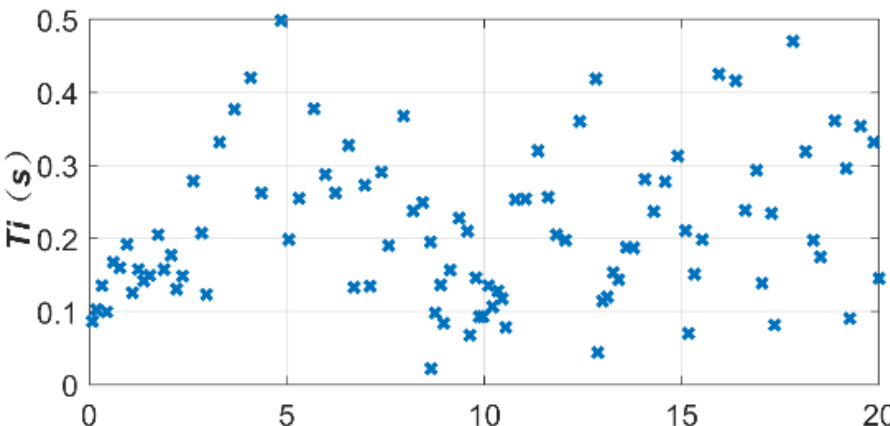
Figure 6. Pitch angle.